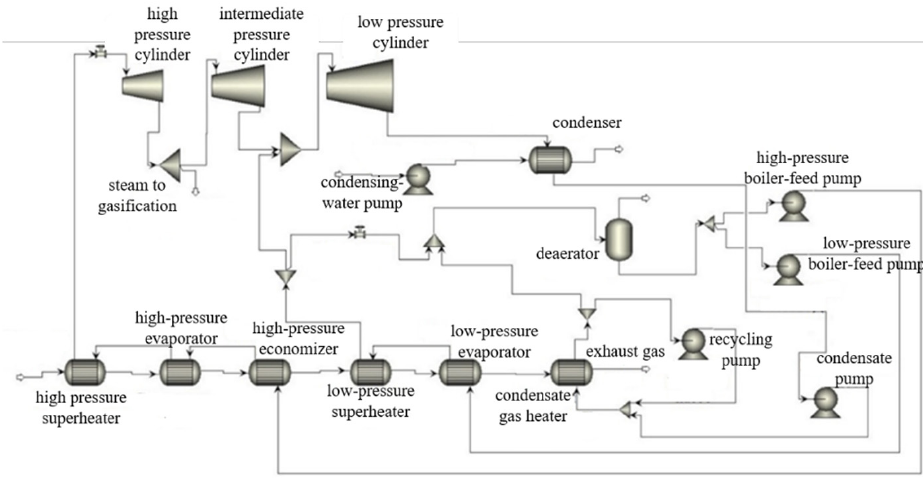
Figure 2. CC facility heat flow scheme simulated with Aspen Plus.